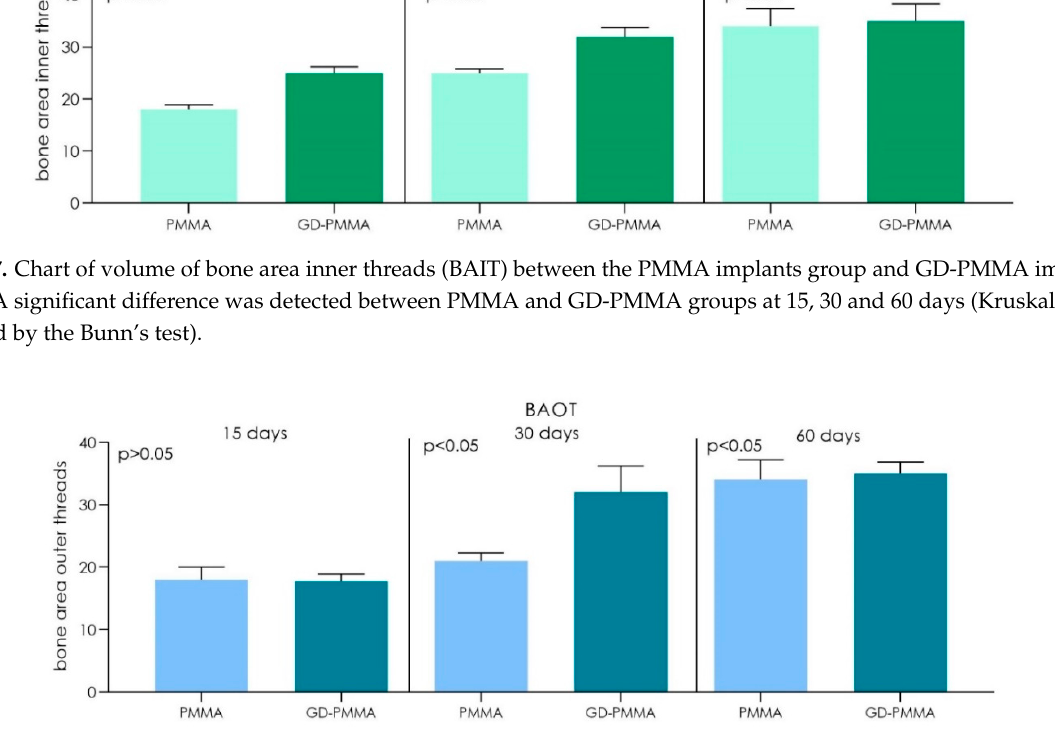
Figure 8. Chart of volume of bone area outer threads (BAOT) between the PMMA implants group and GD-PMMA implants group. A significant difference was detected between PMMA and GD-PMMA groups at 30 and 60 days (Kruskal Wallis followed by the Bunn’s test).